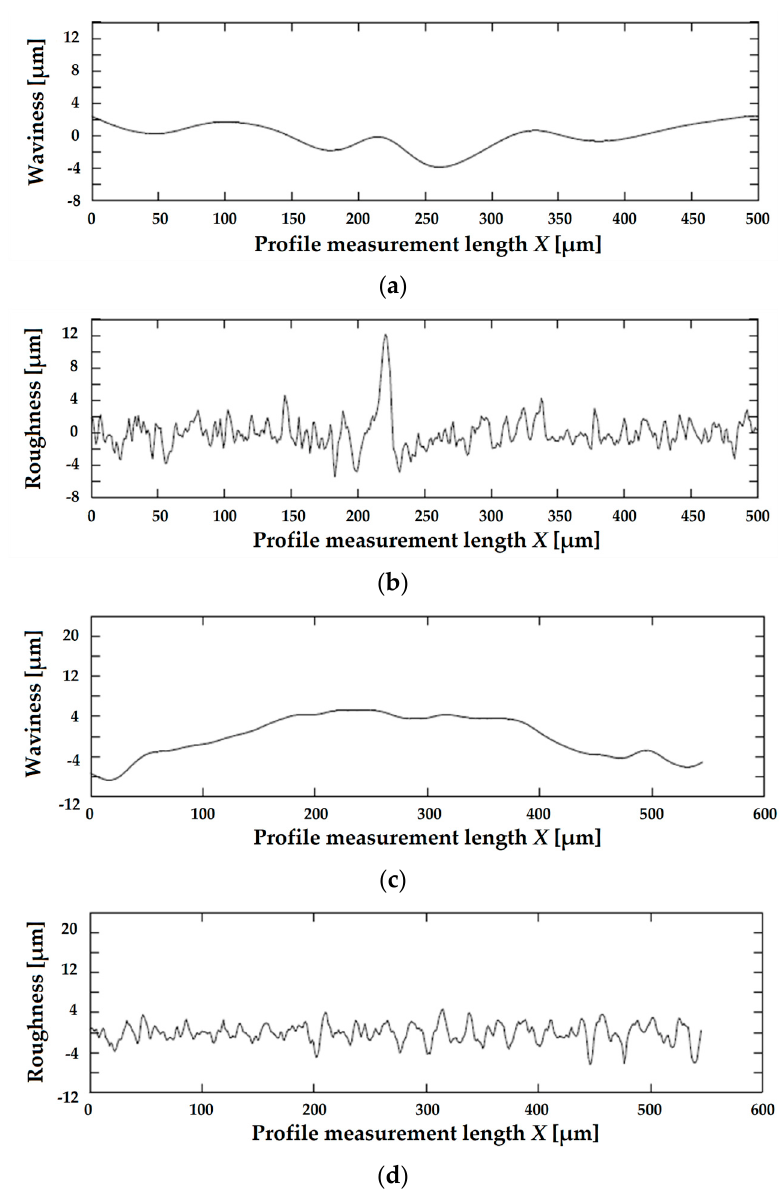
Figure 11. Longitudinal waviness and roughness profile after Gaussian regression (profilometry): ( a ) waviness after laser powder bed fusion method; ( b ) roughness profile after laser powder bed fusion method; ( c ) waviness after vibratory tumbling; ( d ) roughness profile after vibratory tumbling.